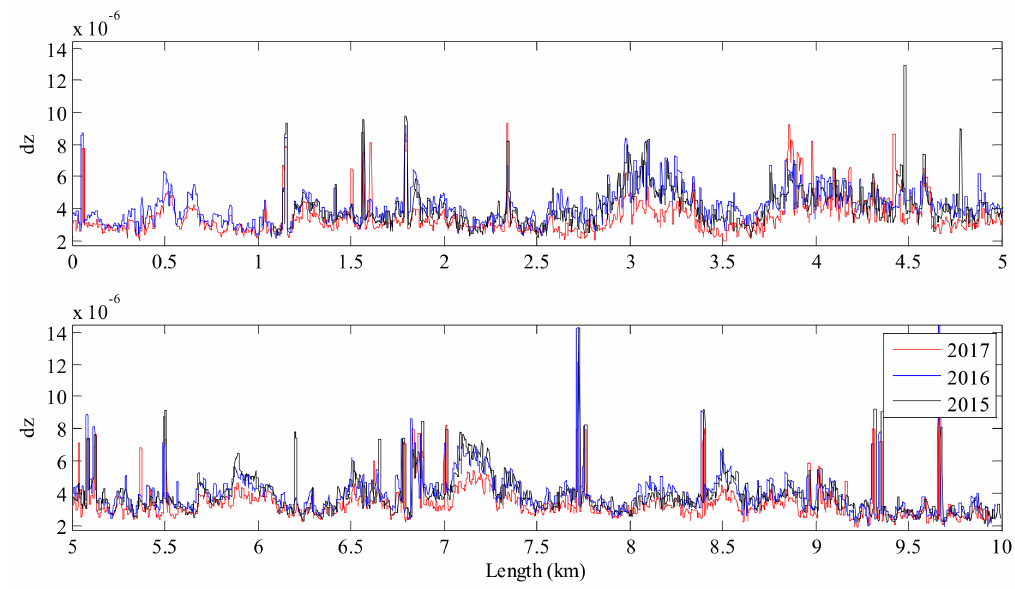
Figure 8. GPR parameter dz , in the time domain, regarding data from the summers of 2015, 2016 and 2017.